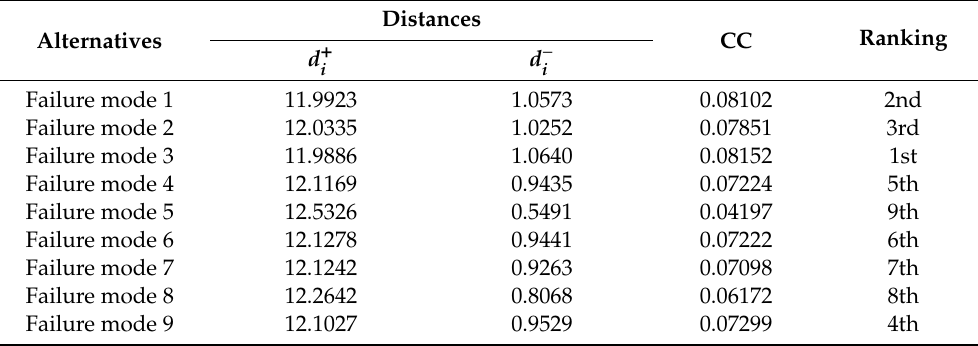
Table 21. The distances, Closeness Coe ffi cients and ranking of failure